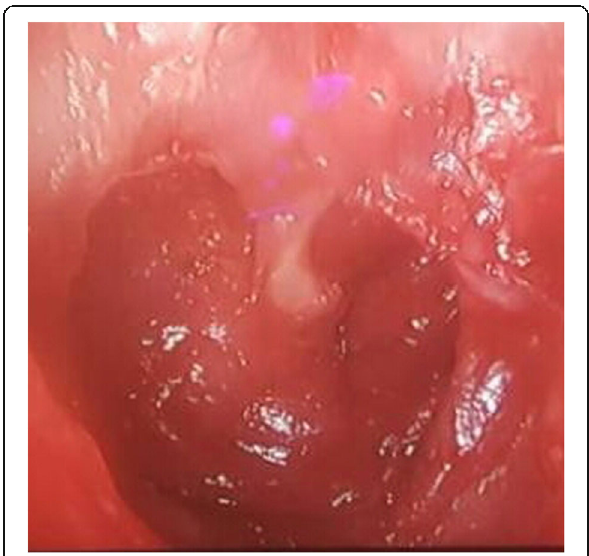
Fig. 3 Adjustment of the graft under handle of the malleus and remnant of TM